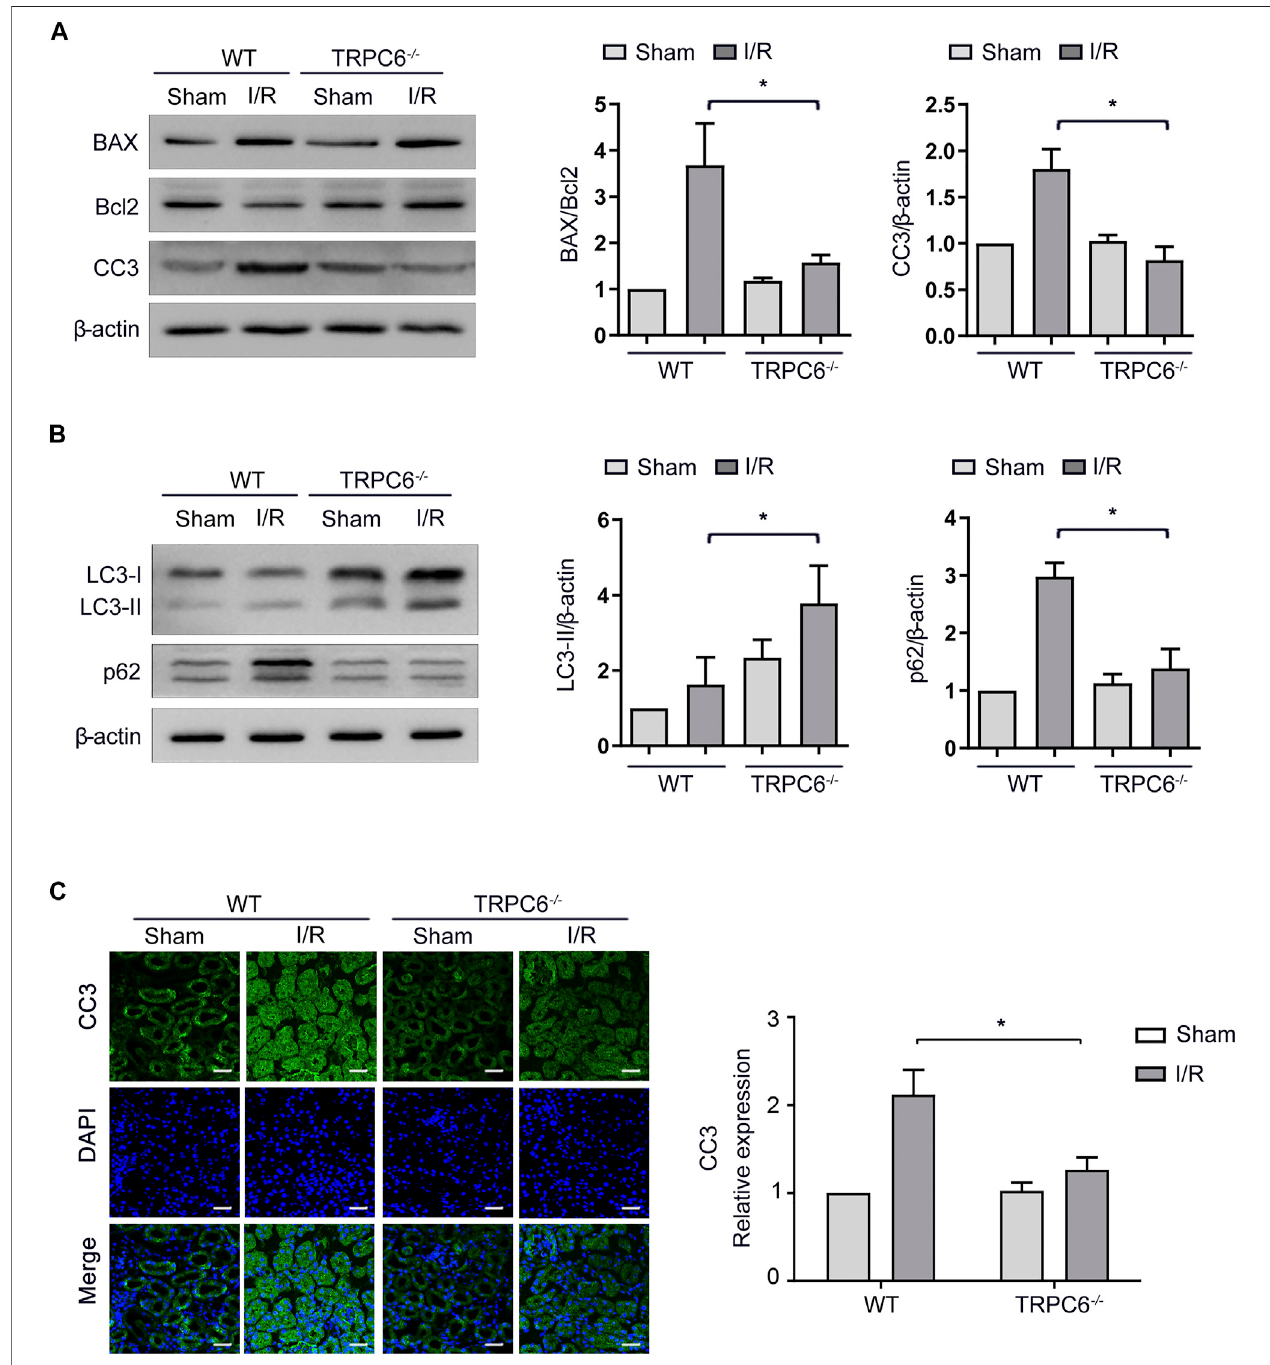
FIGURE4| Autophagyisaugmentedandapoptosisismitigated inTRPC6 − / − mice uponI/R treatment. (A) Representativewestern blotimages ofBAX, Bcl-2, and CC3 expressions in renal tissue lysates extracted from WT and TRPC6 − / − mice subjected to I/R operations. Data are expressed as mean ± SEM, n (cid:2) 3, * p < 0.05. (B) Representative western blot images of LC3-II and p62 expressions in renal tissue lysates extracted from WT and TRPC6 − / − mice subjected to I/R operations. Data are expressed as mean ± SEM, n (cid:2) 3, * p < 0.05. (C) Representative confocal microscopy images of CC3 expression in kidney sections from WT and TRPC6 − / − mice subjected to sham or I/R operations (photographed at a magni fi cation of × 200, scale bar: 50 μ m). Bars represent mean ± SEM, n (cid:2) 6, * p < 0.05.